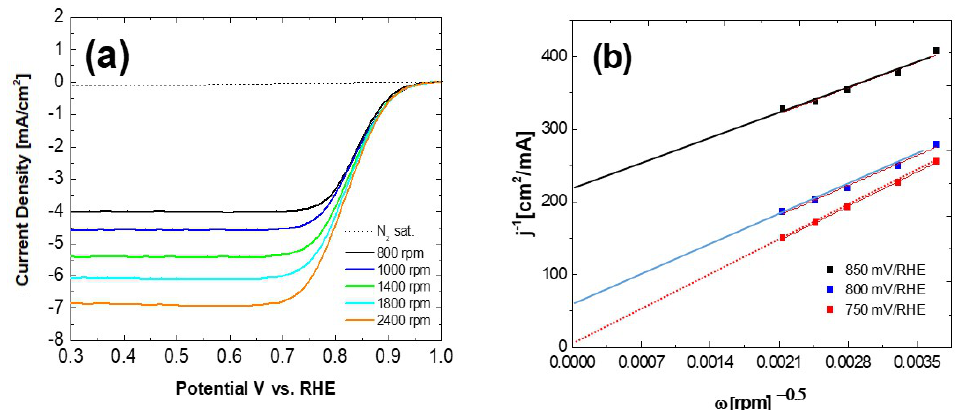
Figure 3. (a) ORR polarization curves for the Pd film prepared at 10 mA/cm 2 DC at different rotation speeds, scan rate 10 mA/s (b) Koutecky–Levich plot for Pd film deposited at 10 mA/cm 2